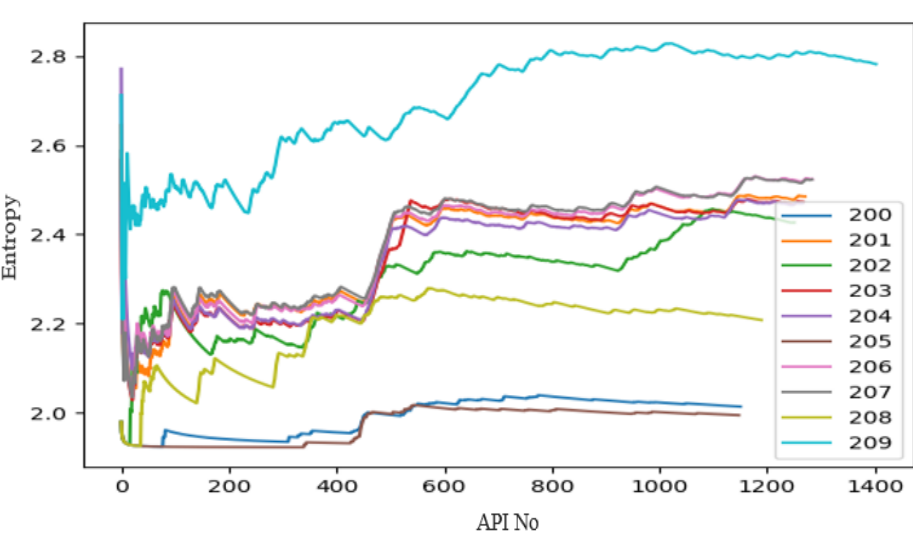
Figure 1. Entropy-based API call distribution of benign.